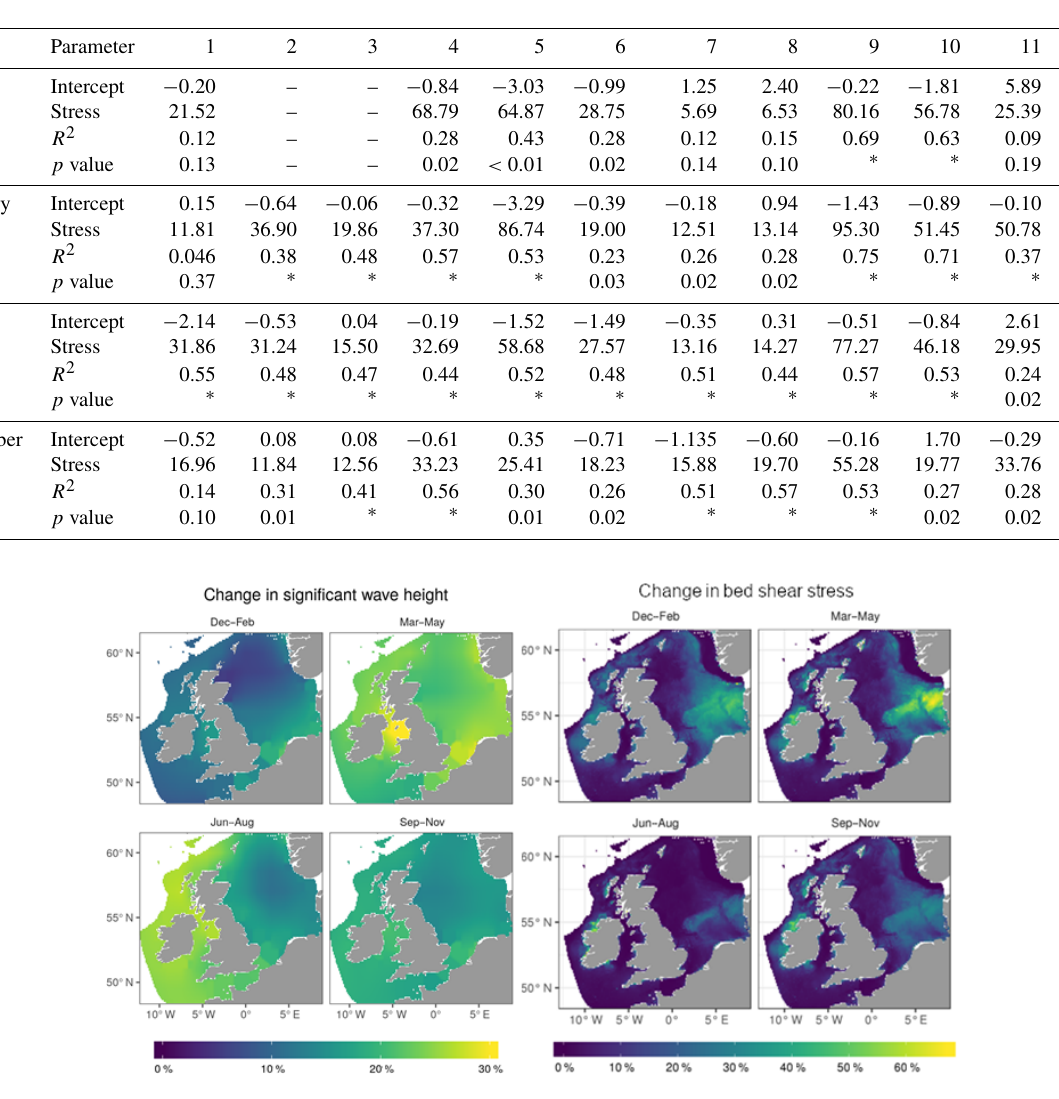
Table 2. Results of linear regressions of monthly SPM and bed shear stress for the boxed regions 1–12 mapped in Fig. 5. A dash (–) indicates there are insufficient data for a regression; p values below 0.01 are indicated with an asterisk ( ∗ ).